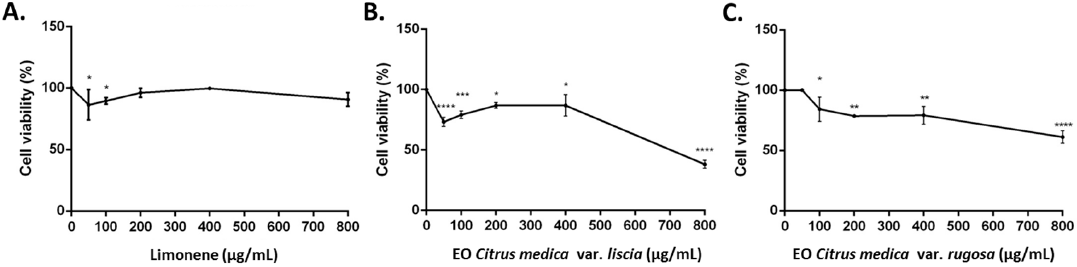
Figure 3. Percentage of cell viability after 3-(4,5-dimethylthiazol-2-yl)-2,5-diphenyl tetrazolium bromide (MTT) assay. Cells were treated with different concentrations (50–800 µ g/mL) of limonene ( A ); C. medica cv. ‘liscia’ ( B ) and C. medica cv. ‘rugosa’ EOs, for 24 h and solvent (DMSO, 0.1%) alone. Data are the mean ± SD of three experiments * p < 0.05, ** p < 0.01, *** p < 0.001, **** p < 0.0001 vs. DMSO